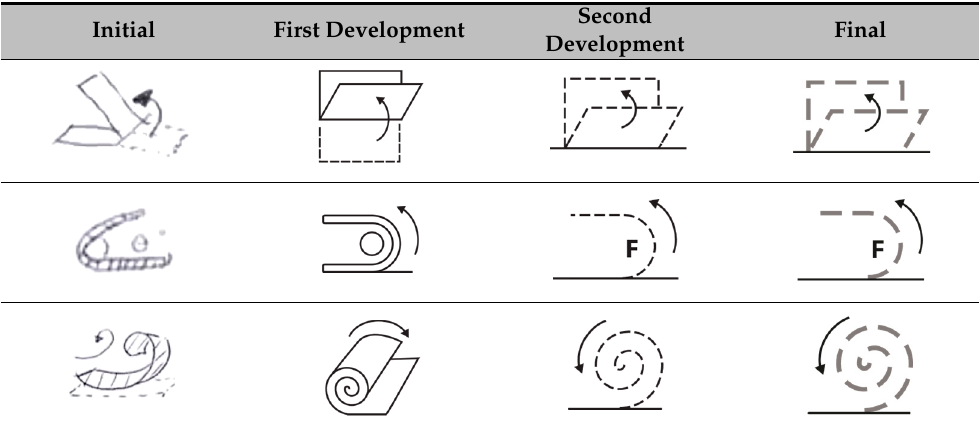
Table 2. The symbol development process for shape-changes behaviours.